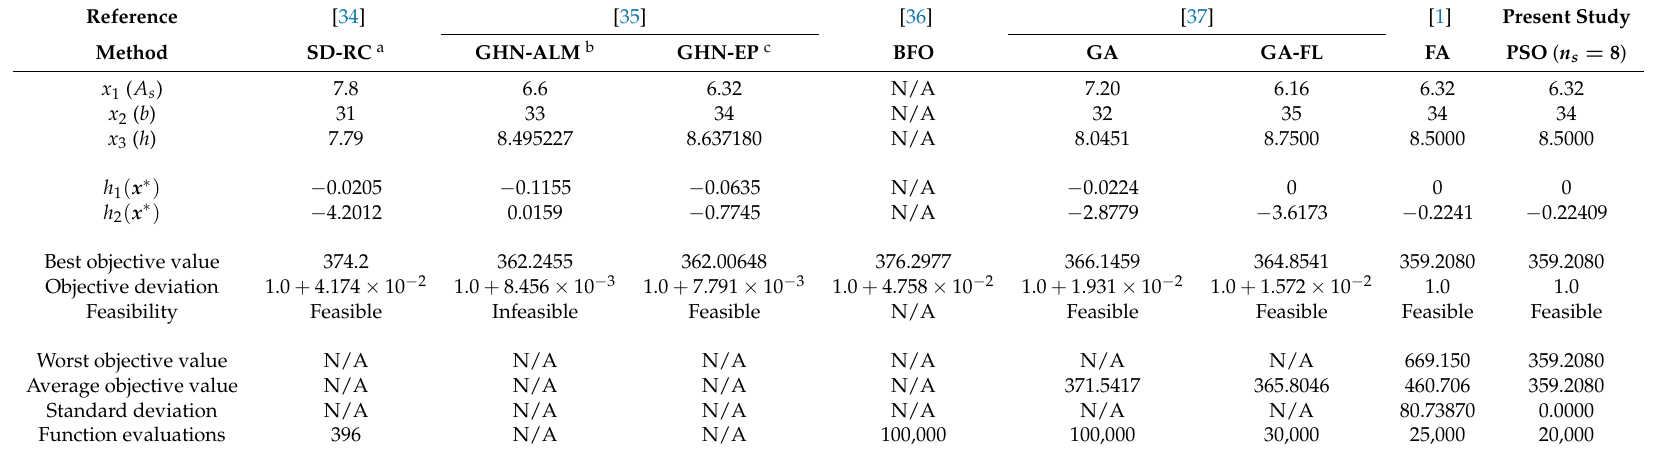
Table 3. Optimization results of the reinforced concrete beam design